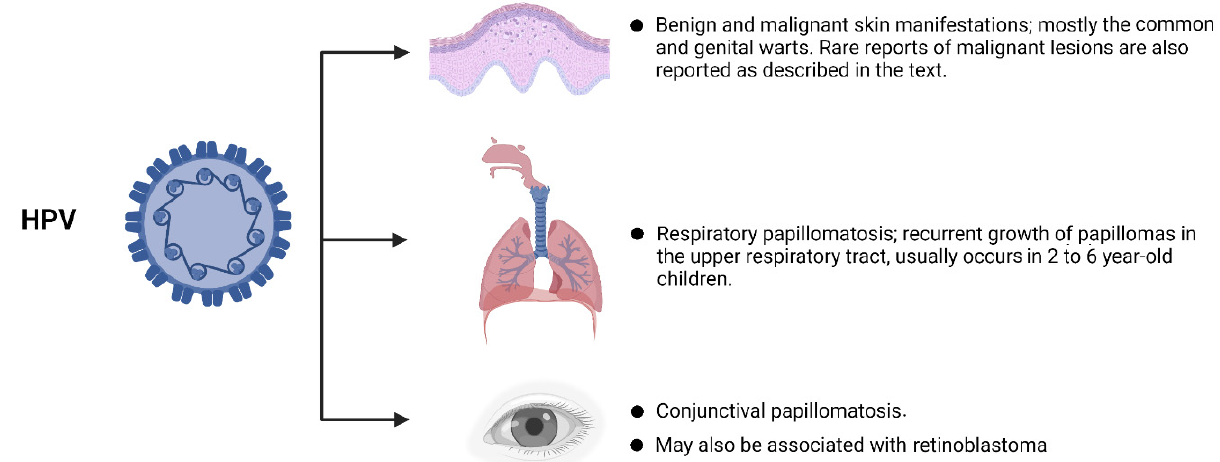
Figure 2. Manifestations of HPV in childhood. Created with BioRender.com, accessed on 6 July 2022.